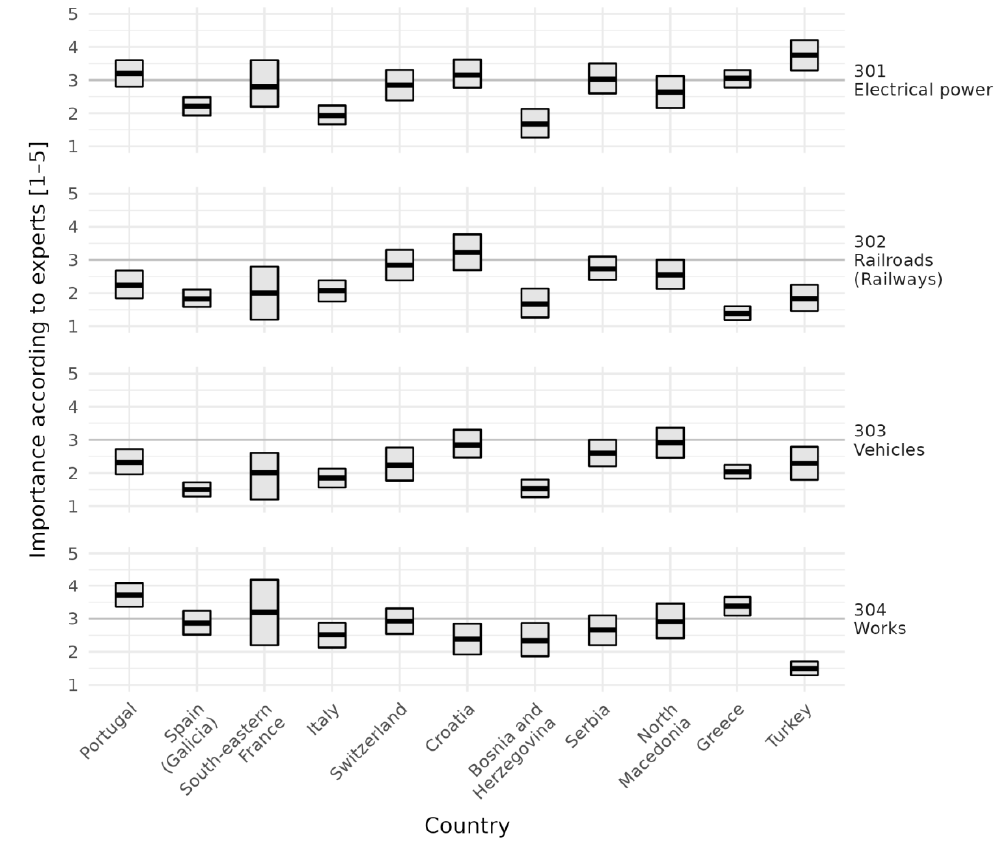
6 Figure 6. Crossbar plot of the importance of ignitions due to Accident causes , according to the smean.cl.boot function from the Hmisc R-package, grouped by